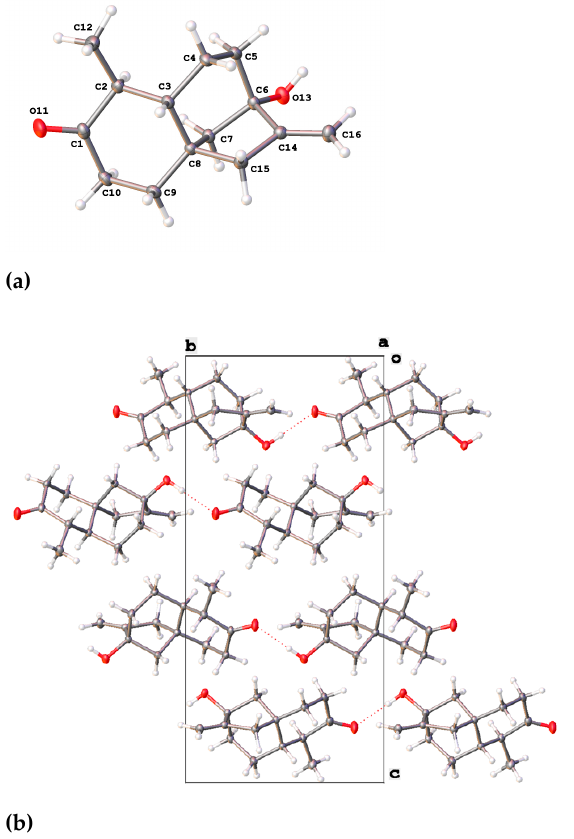
Figure 2. (a) X-ray structure of monicanone with ellipsoids drawn at the 50% probability level. (b) A view down the a axis of the crystal packing showing the O-H ∙∙∙ O interactions (red dashed